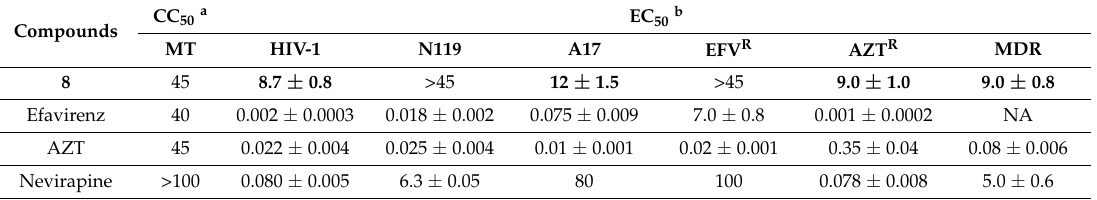
Table 7. Cytotoxicity and antiviral activity of tryptamine derivative 8 against HIV-1 and its NRTI- and NNRTI-resistant mutants .